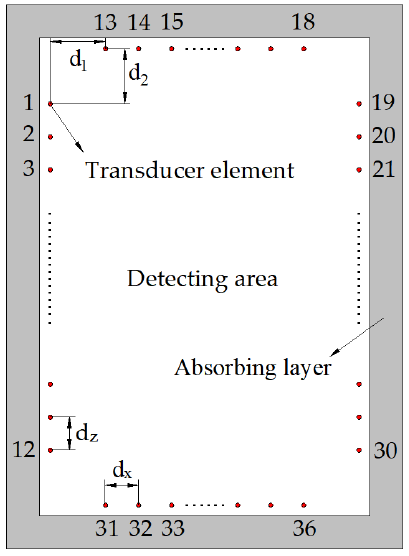
Figure 3. Configuration of the ultrasonic transducer array.